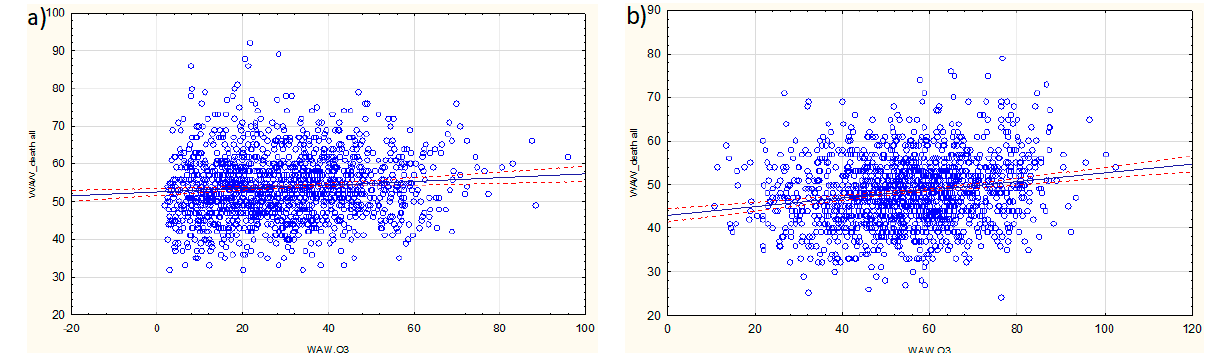
Figure 3. Association between daily ozone (WAW.O 3 ) concentrations and mortality in Warsaw (WAW_death all): ( a ) winter season; ( b ) summer season. Regression line is shown in blue, and 95% confidence intervals are shown as dashed red lines.